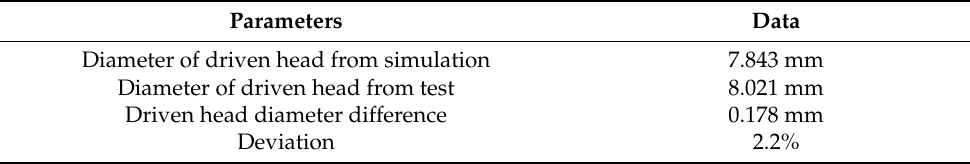
Figure 8. Automatic drilling and riveting machine pressure riveting test. Table 3. Driven head size data comparison between simulation and riveting